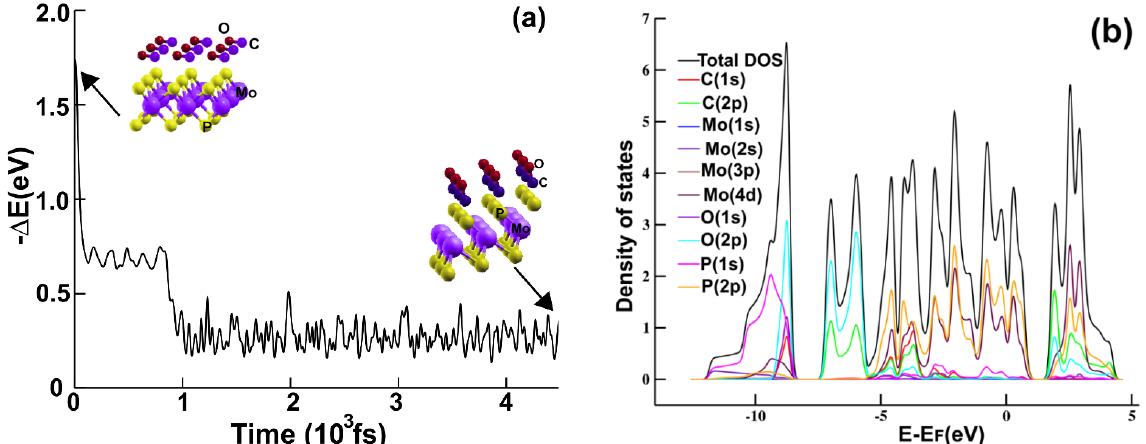
Figure 3. ( a ) Time evolution of the energy in the adsorption of the carbon monoxide molecule on the 2D MoP 2 surface at atmospheric pressure and 300 K. The adsorption energy is − 0.9398 eV, and the final distance from the carbon atom to the plane is 1.3622 Å. ( b ) PDOS for the carbon monoxide molecule adsorbed on the 2D MoP 2 surface.